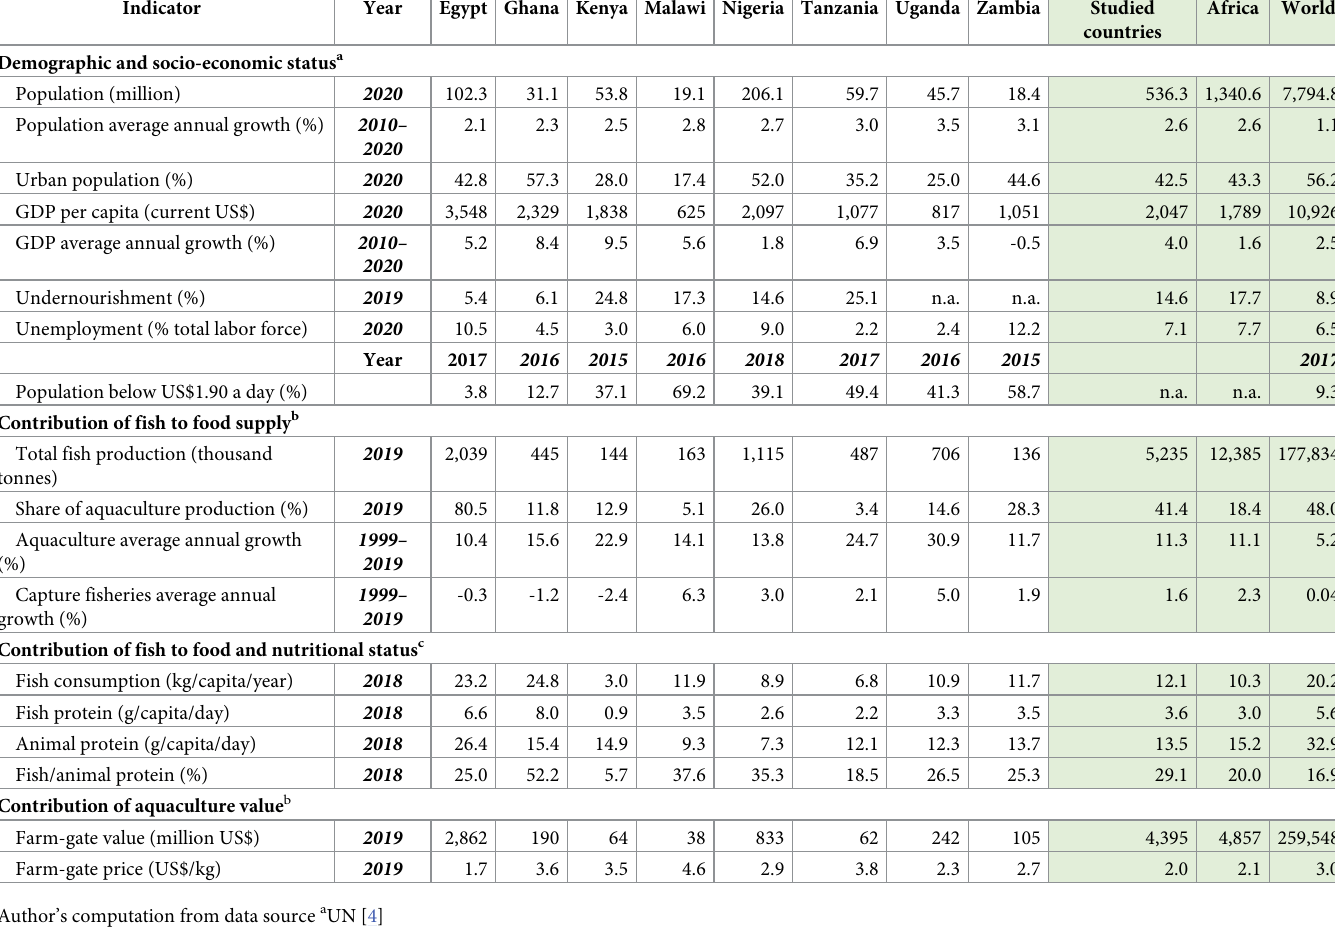
Table 1. Contribution of fish to food security in Africa and the